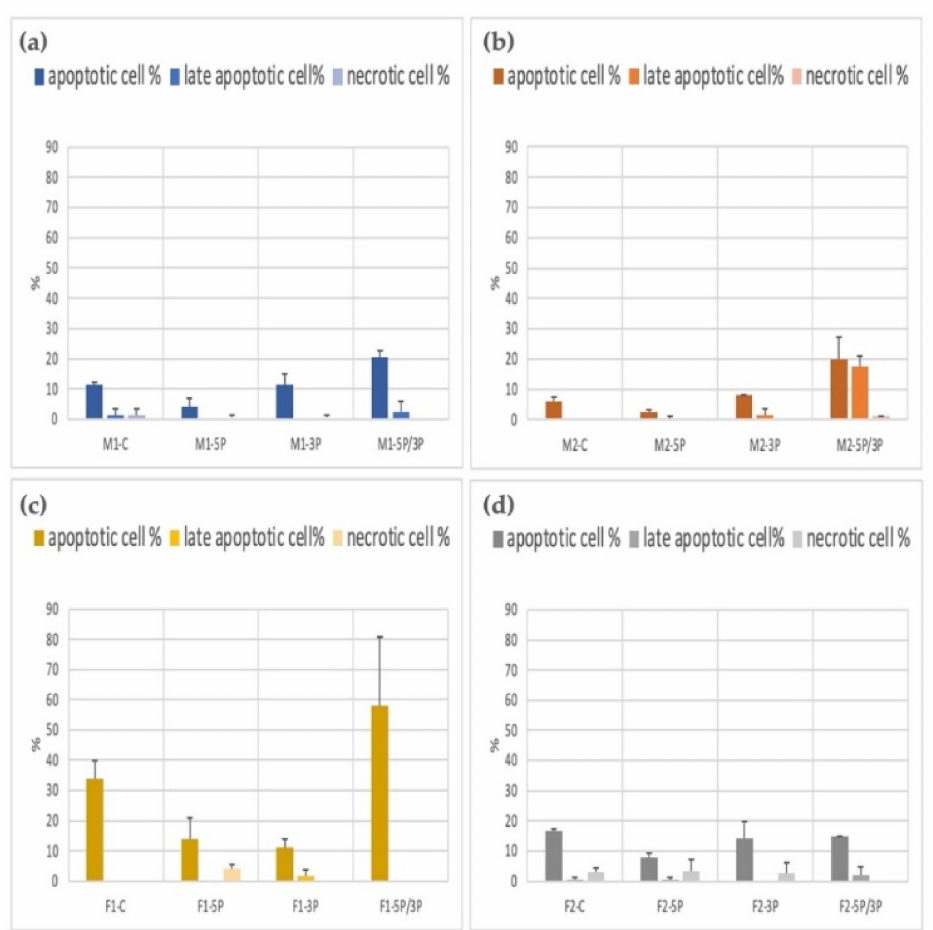
Figure 9. Comparison of the apoptotic, late apoptotic, and necrotic cell percentage in M1 ( a ), M2 ( b ) (ZZ genotype) and F1 ( c ), F2 ( d ) (ZW genotype) PGC lines.: C: non-inhibited, 5P: gga-miR-302b-5P inhibition, 3P: gga-miR-302b-3P inhibition, 5P/3P: gga-miR-302b-5P andgga-miR-302b-3P